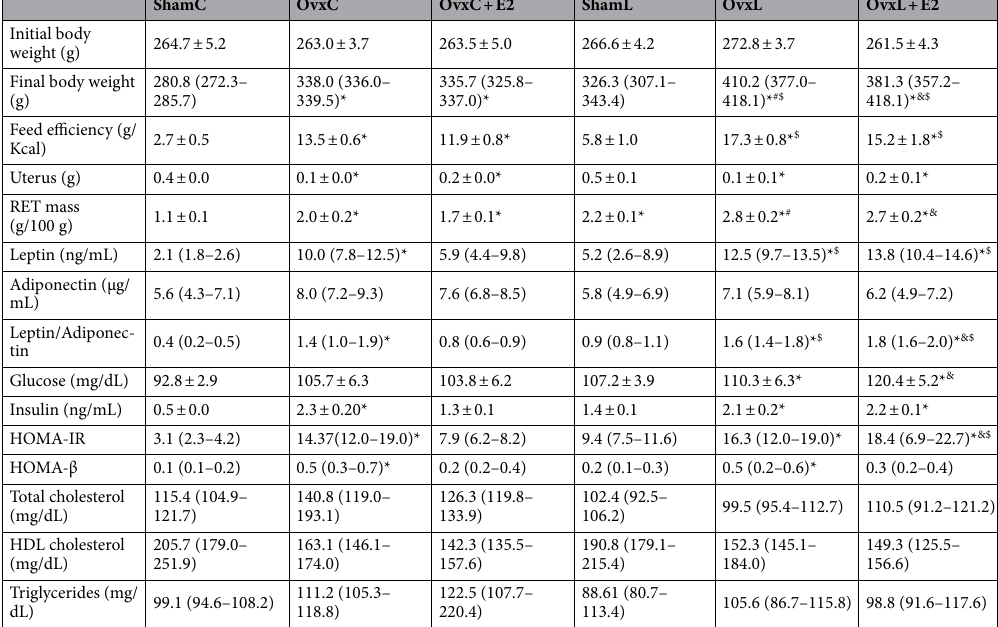
Table 1. Body and serum parameters of ovariectomized (Ovx) or Sham operated rats, fed a control (C) or lard-enriched (L) diet, subjected or not to oestrogen replacement therapy (E2). Data presented as mean ± standard error (SE) for variables with normal distribution or median-interquartile range (Q1-Q3) for variables not normally distributed. n = 6 animals per group. * p < 0.05 vs. ShamC;# p < 0.05 OvxC vs.OvxL;& p < 0.05 OvxC + E2 vs.OvxL + E2; $ p < 0.05